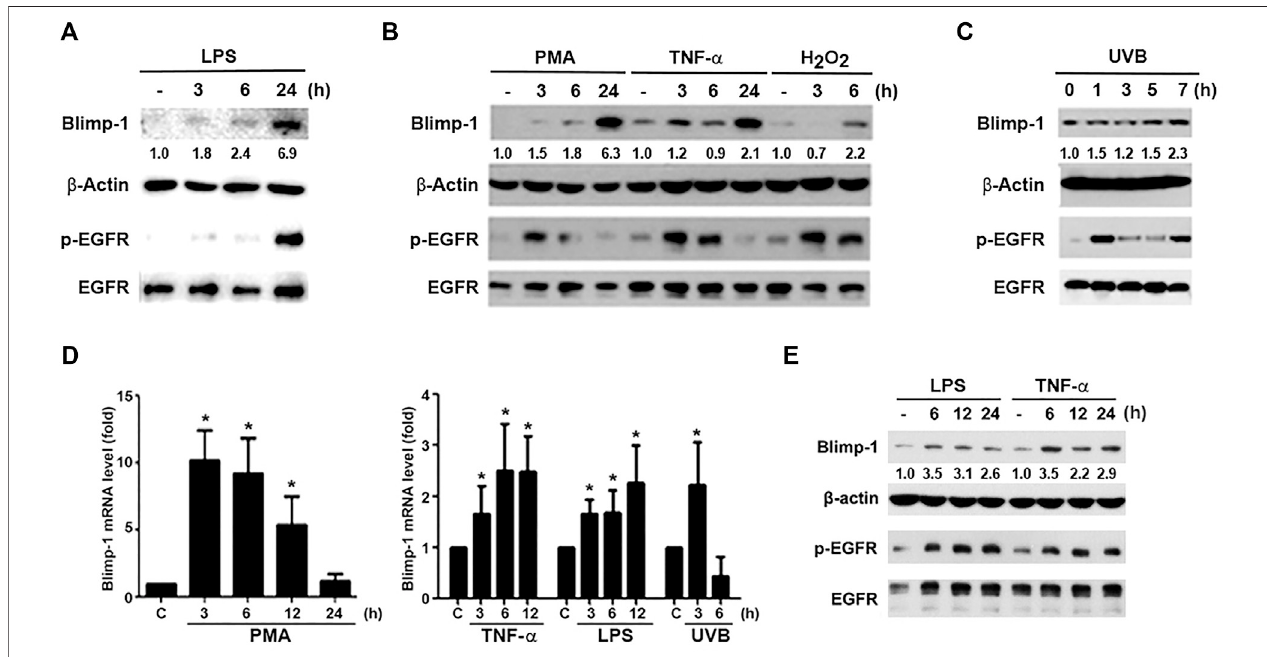
FIGURE1| LPS,PMA,TNF- α ,UVB,andH 2 O 2 upregulateBlimp-1geneandproteinexpressionsinHaCaTcellsandNHEKs.HaCaTcellswerestimulatedwithLPS (1 μ g/ml) (A) ,PMA (30 nM), TNF- α (10 ng/ml), H 2 O 2 (200 μ M) (B) or UVB (50 mJ/cm 2 ) (C) for indicated time periods. (E) NHEKswerestimulated withLPS(1 μ g/ml)and TNF- α (10 ng/ml) for indicated times. After stimulation cell lysates were collected to determine Blimp-1 and β -actin expression by immunoblotting. (D) HaCaT cells were stimulated with PMA (30 nM), TNF- α (10 ng/ml), LPS (1 μ g/ml), or UVB at 50 mJ/cm 2 for indicated time periods and then Q-PCR was performed to evaluate the mRNA level of Blimp-1. * p < 0.05 (mean ± S.E.M., n = 5) as compared to control